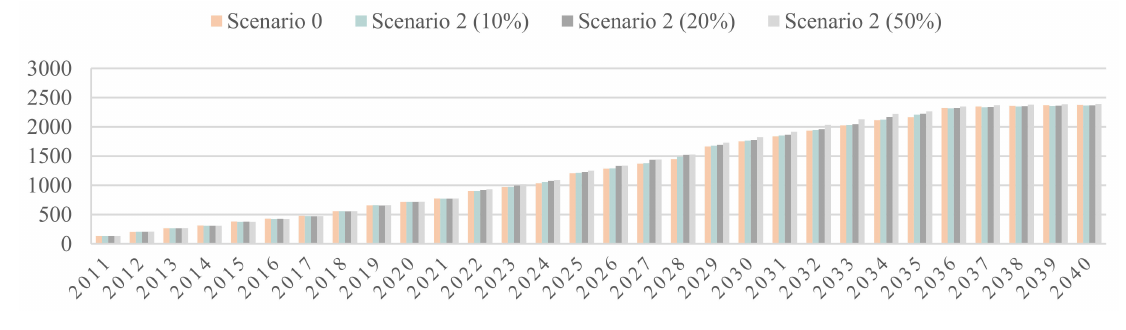
Figure 8. Comparison between Scenario 0 and Scenario 2.